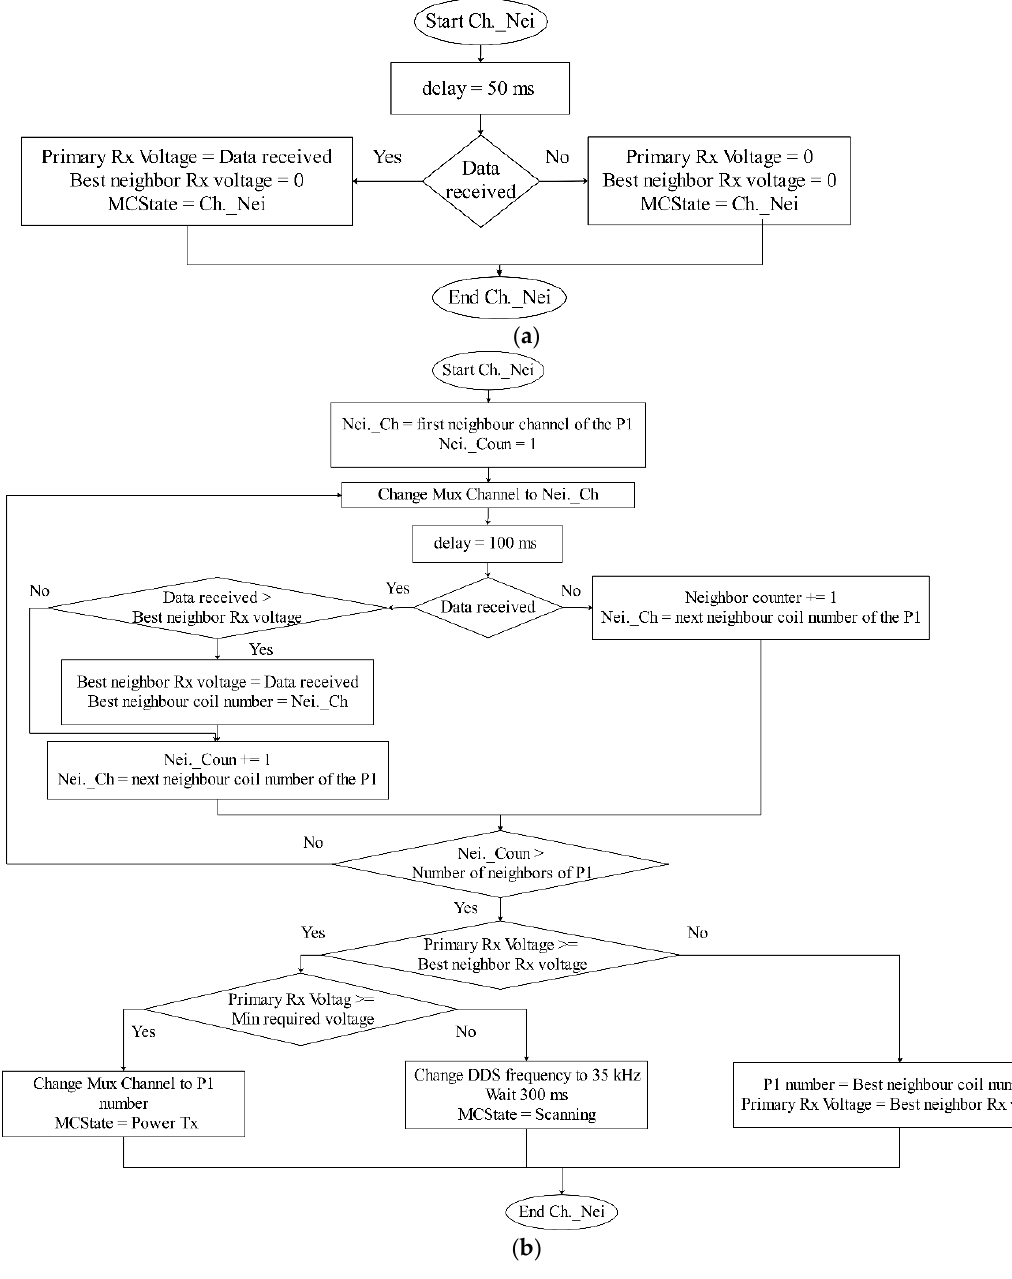
Figure 9. Flowchart sub-algorithm: ( a ) Check communication phase, ( b ) check coils neighbor phase.